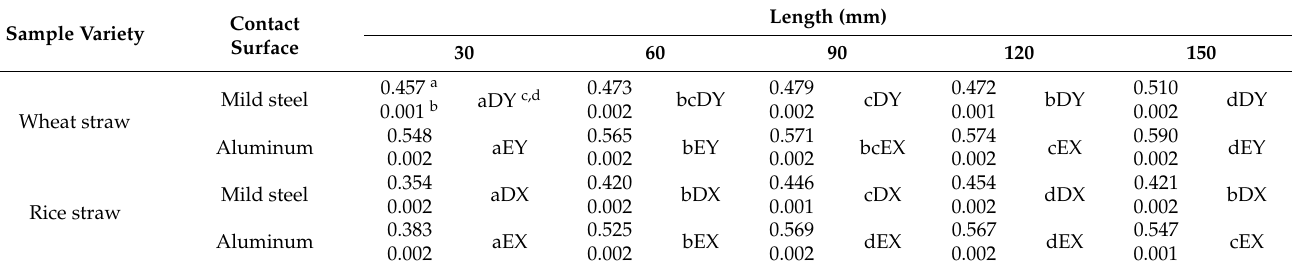
Table 6. Coefficient of sliding friction for different lengths of straw on mild steel and aluminum surfaces.